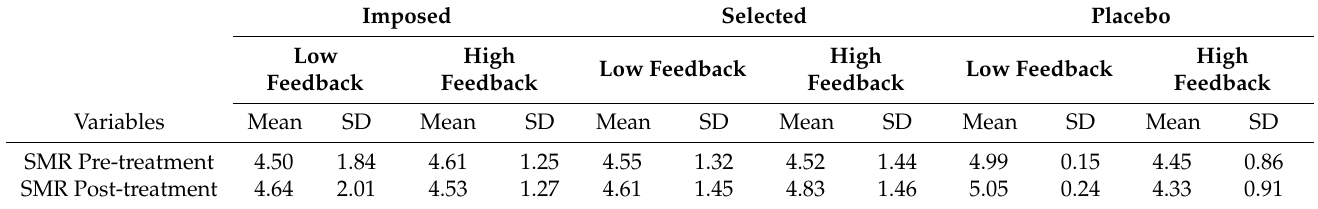
Table 3. SMR raw scores for each